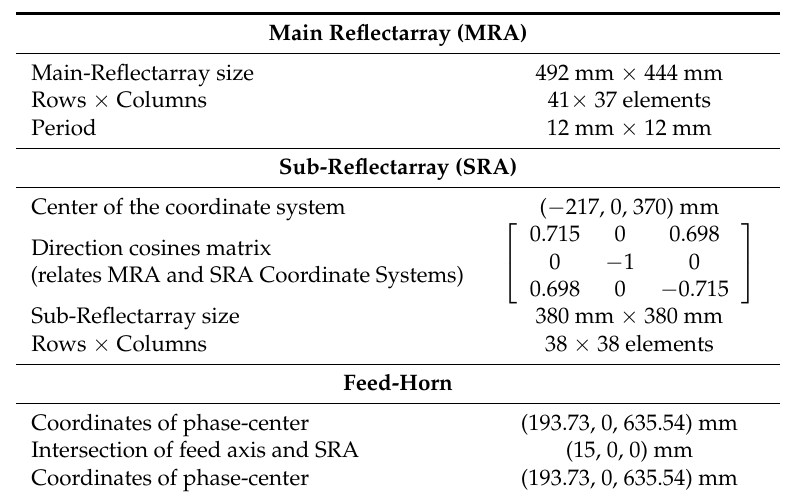
Table 1. Geometrical parameters of the dual-reflectarray antenna.